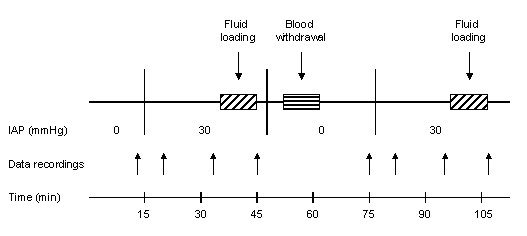
Flow chart of the experimental protocol.